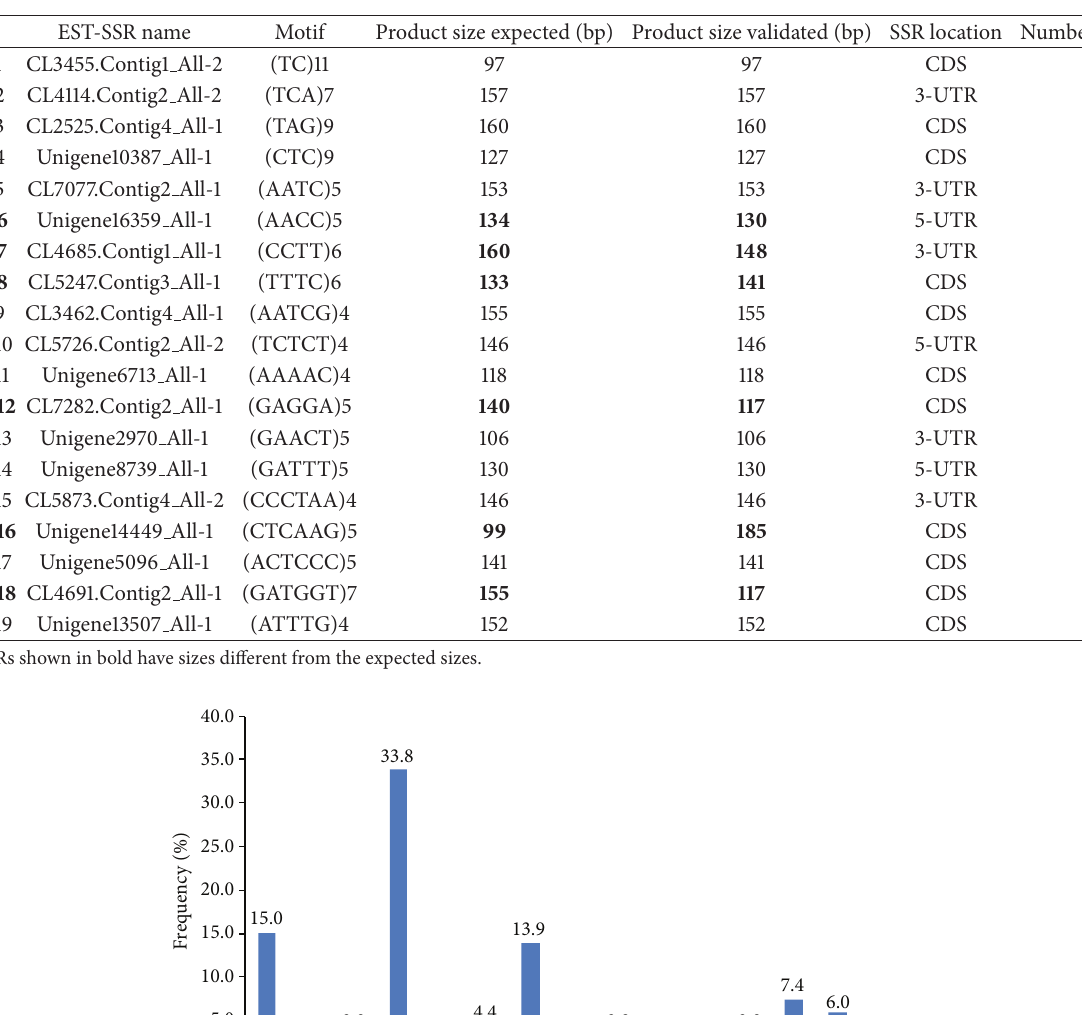
Table 3: Details of 19 EST-SSRs that successfully yielded PCR amplicons in FuShanBaoTou.